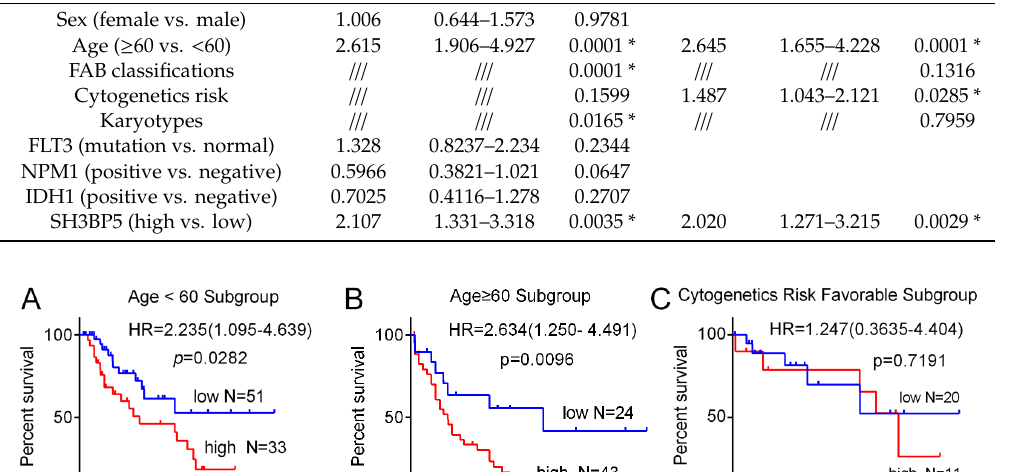
Figure 3. Relationship between SH3BP5 expression and age or cytogenetics risk in AML patients. Kaplan–Meier analysis of overall survival in patients with age < 60 ( A ) or age ≥ 60 ( B ) subgroup